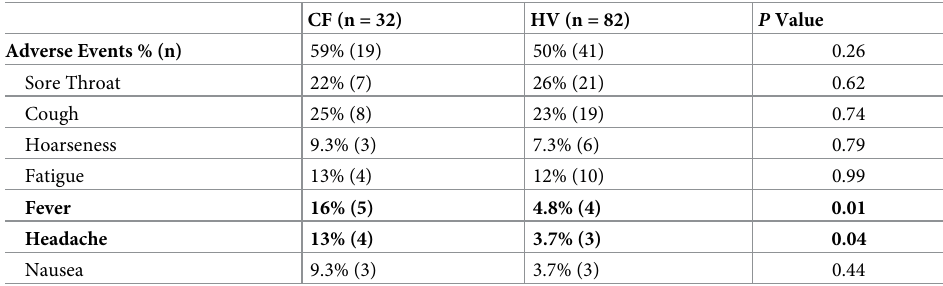
Table 2. Adverse